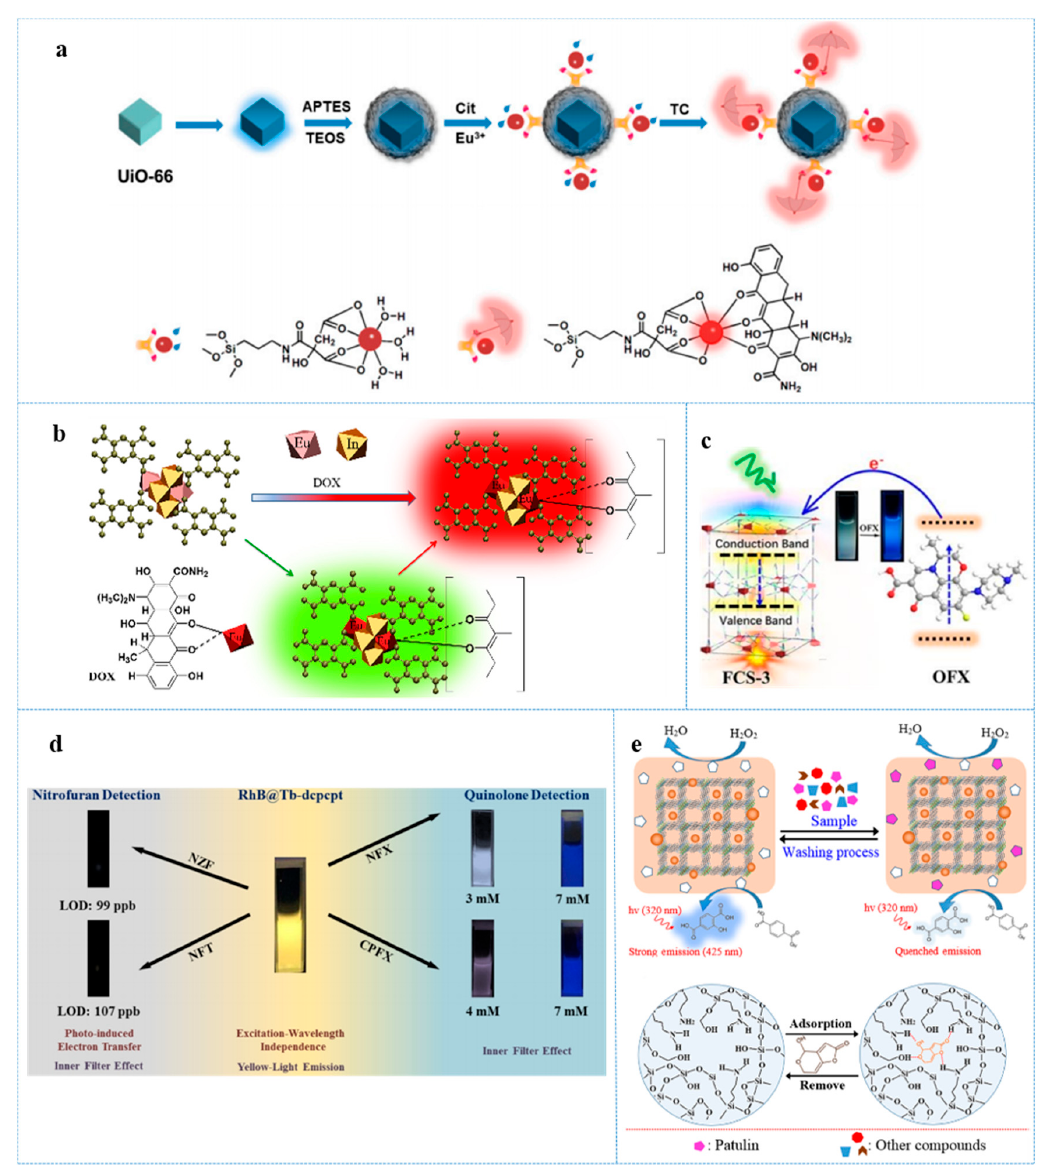
Figure 2. ( a ) Schematic diagram for the fabrication procedure of a Dye@UiO-66-@SiO 2 -Cit-Eu nano-probe and the